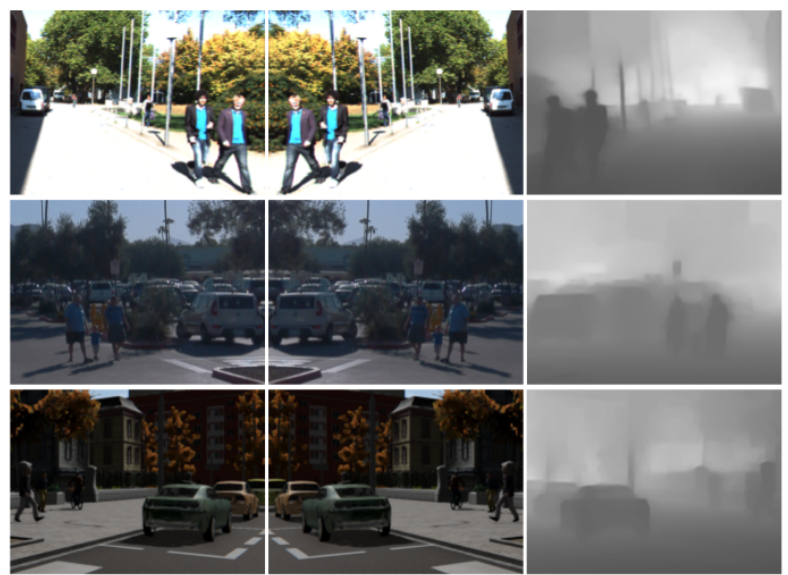
Figure 1. From top to bottom: samples from KITTI ( K ), Waymo ( W ), and Virtual-world ( V ) datasets. Middle column: cropped patch from an original image. Left column: horizontal mirror of the original patch. Right column: monocular depth estimation [18] from the original patch. Left-middle columns are the views used for co-training in [17]. Right-middle columns are the views also used in this